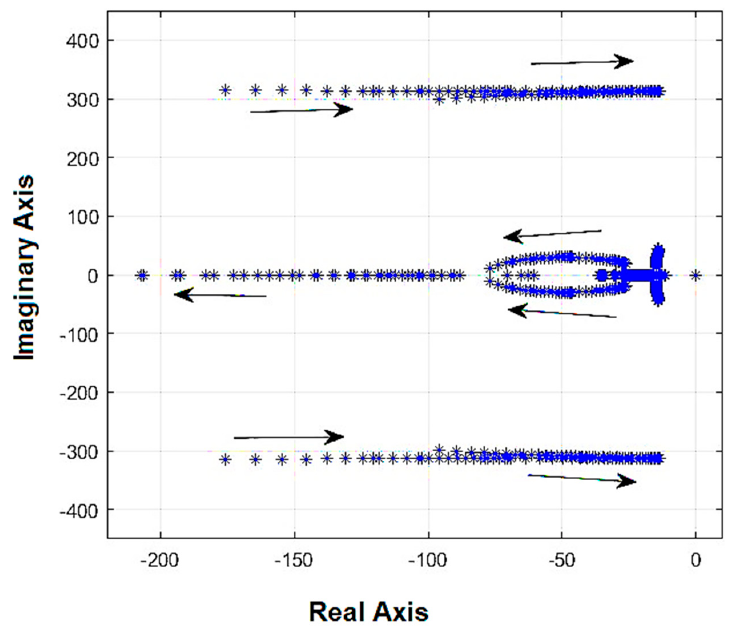
Figure 18. The root locus of the proposed system.